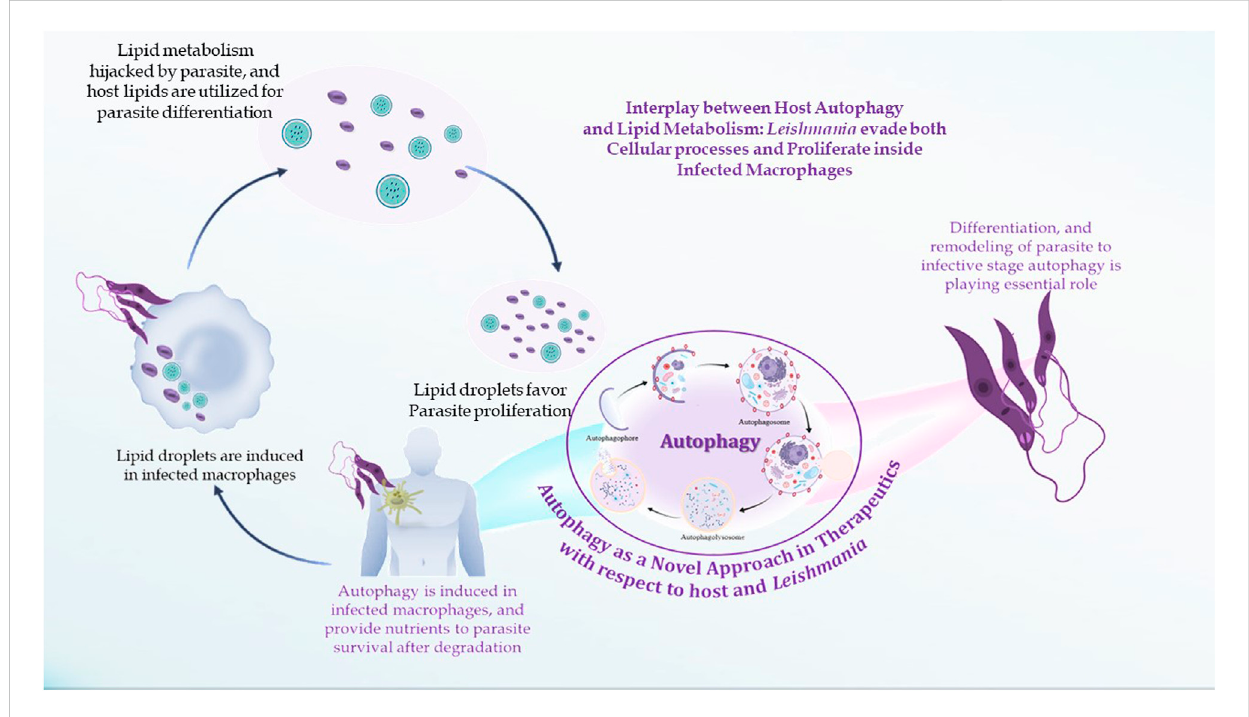
FIGURE 5 Interplay between lipid metabolism and autophagic